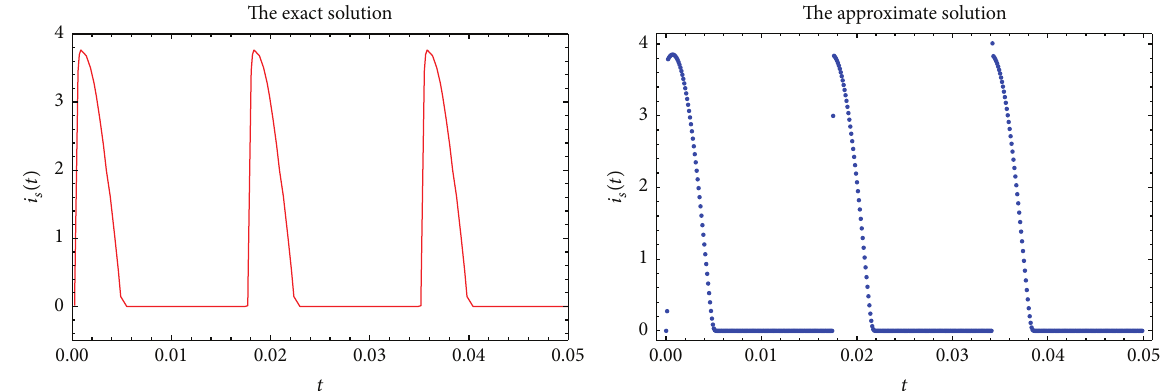
Figure 2: The exact and approximate solutions for the current of the diode circuit.